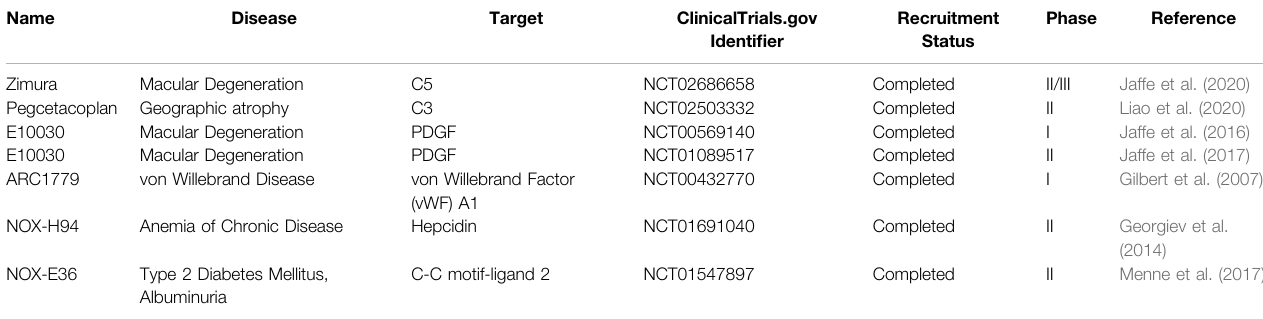
TABLE 2 | Aptamer in clinical